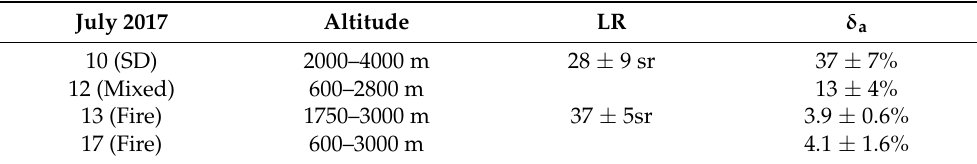
Table 3. Mean values of AOD, LR and δ a derived from lidar observations and measured in the layers observed in the time period 10–17 July